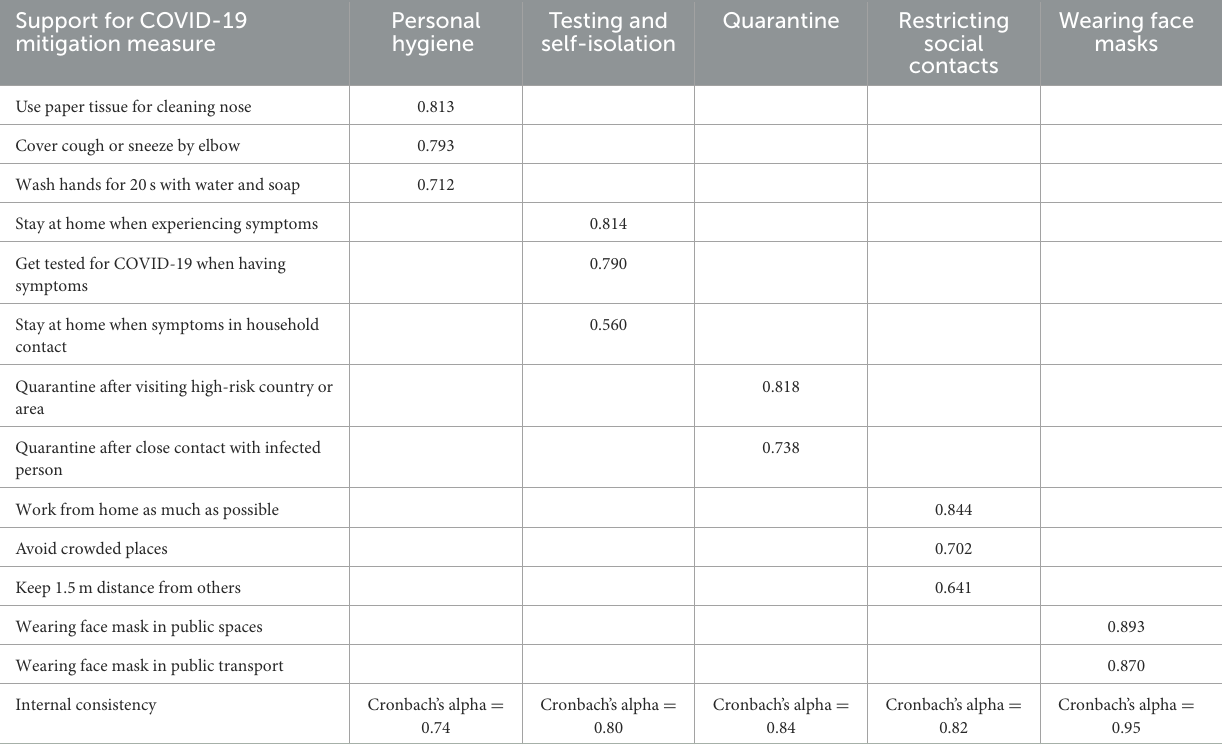
TABLE 1 Item loadings ∗ and internal consistency of five multi-item components # resulting from principal component